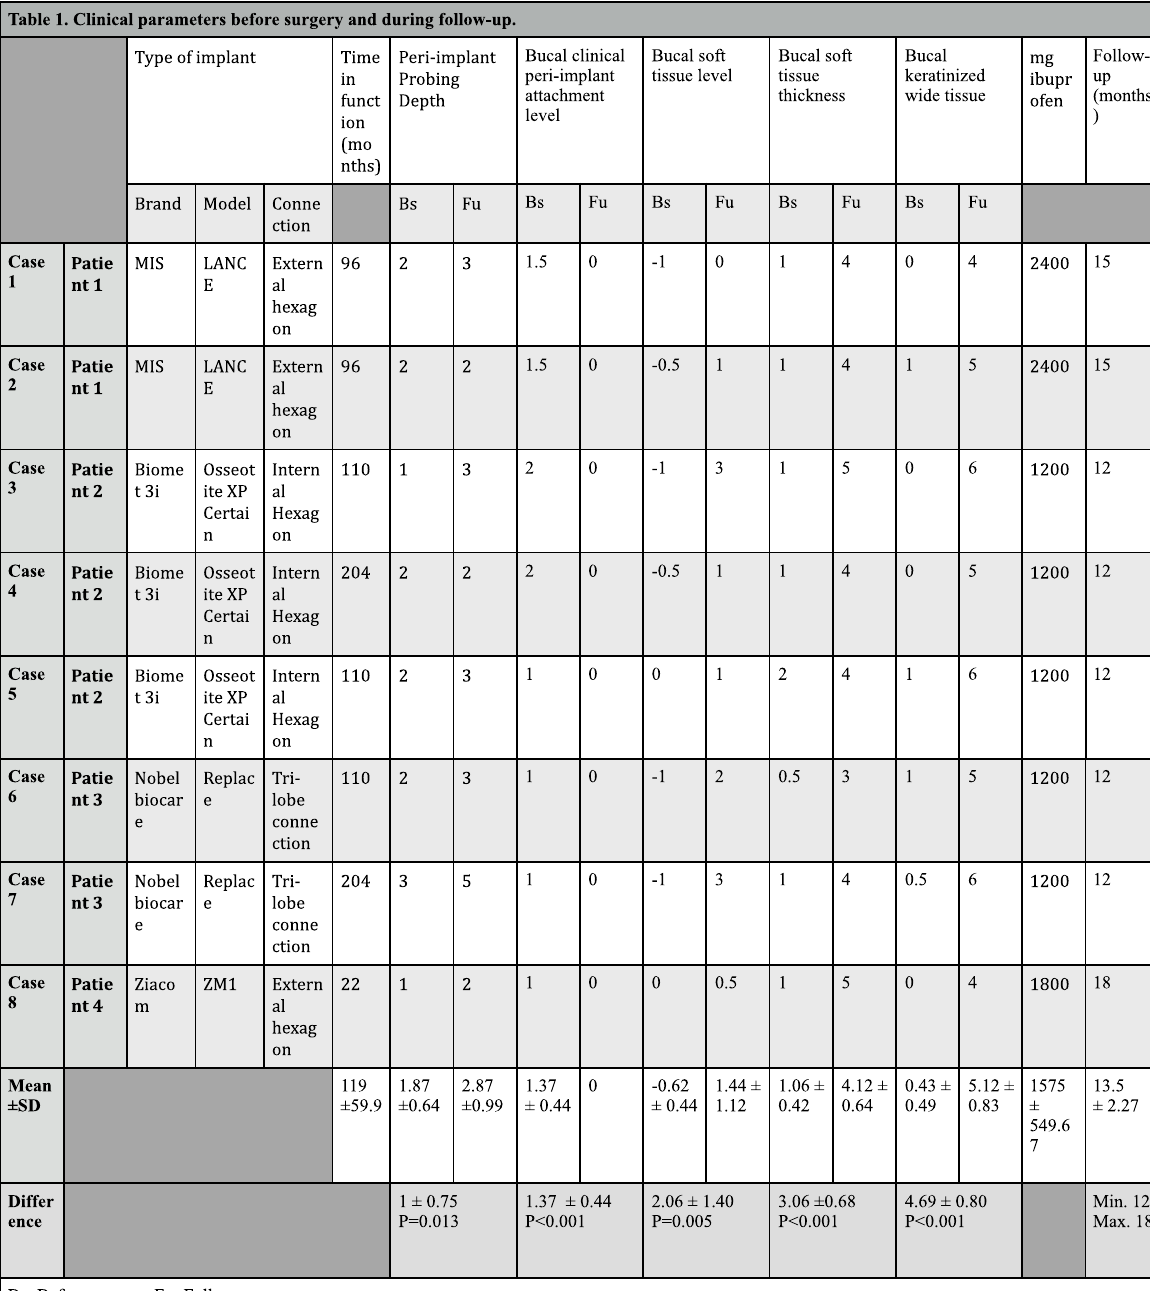
Table 1 Clinical parameters before surgery and during follow-up